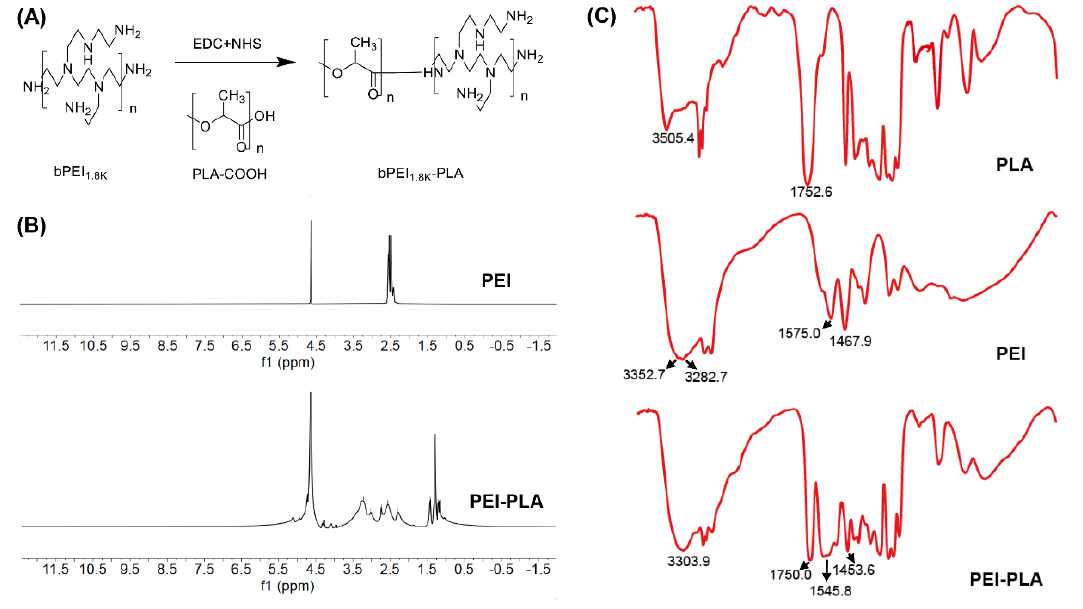
Figure 2. ( A ) Synthesis of PEI-PLA. ( B ) 1H-NMR spectra of PEI and PEI-PLA. ( C ) FTIR spectra of PLA-COOH and PLA-COOH and PEI-PLA.